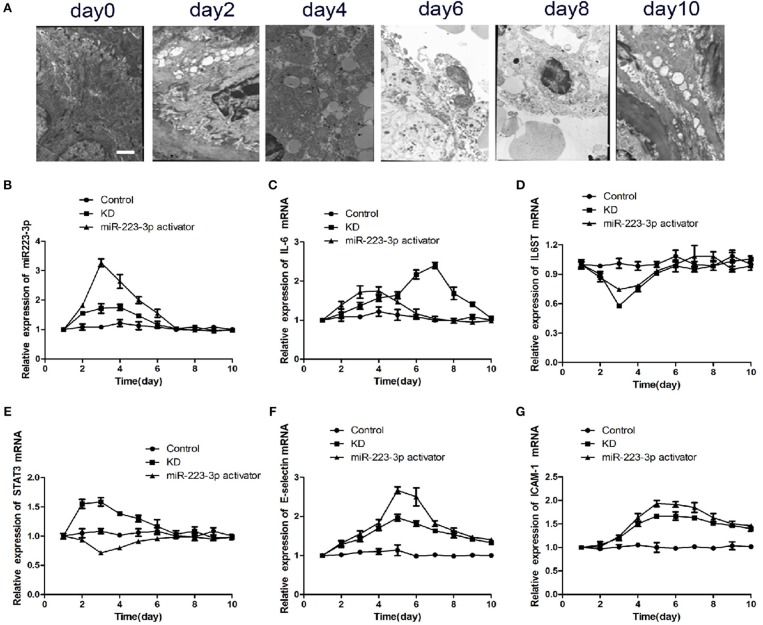
miR-223-3p regulated the inflammatory factor levels in KD mice. (A) Representative SEM images of CAWS induced KD mice model at different stages. The Scale bar was “×5000.” Relative expression levels of (B) miR-223-3p, (C) IL-6, (D) IL-6ST, (E) STAT3, (F) E-selectin, and (G) ICAM-1 in control mice, KD mice, and miR223-3p activator treated KD mice with respect to time.